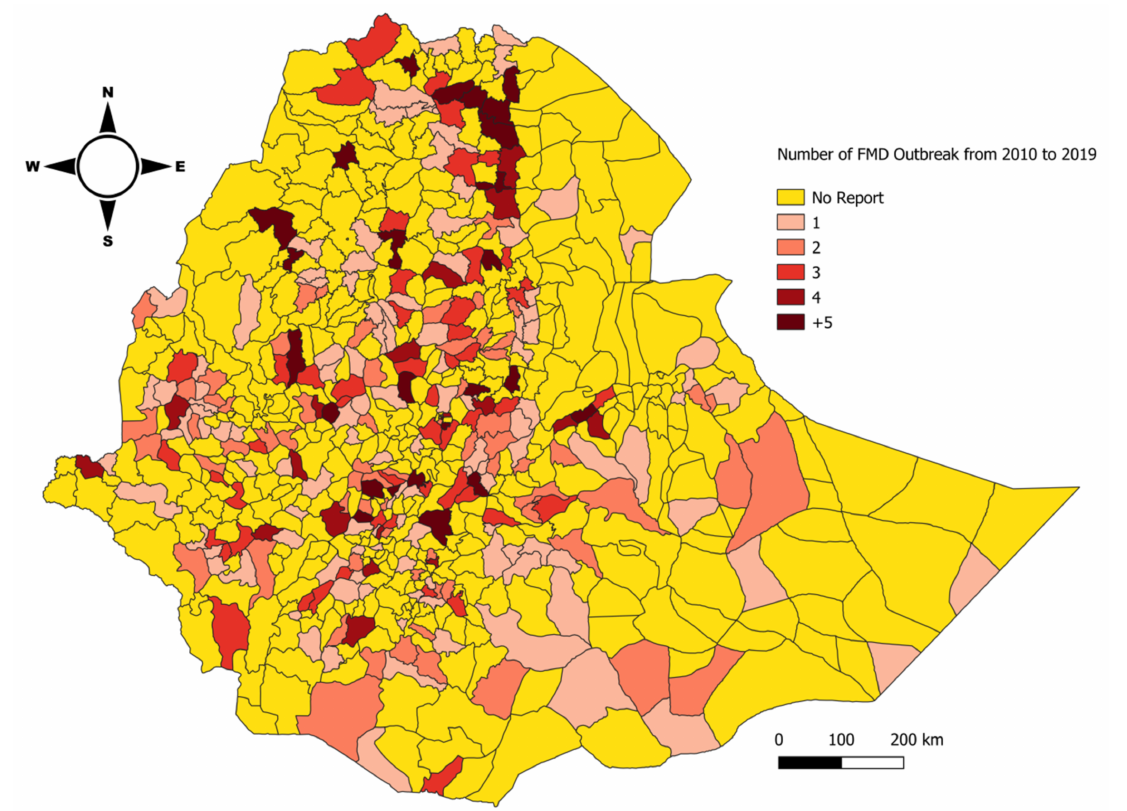
Figure 5. Map showing the Federal Democratic Republic of Ethiopia as of February 2022. The grey lines in the map indicate the district level administrative divisions. The shaded area shows district cumulative FMD outbreak reports in Ethiopia from 2010 to